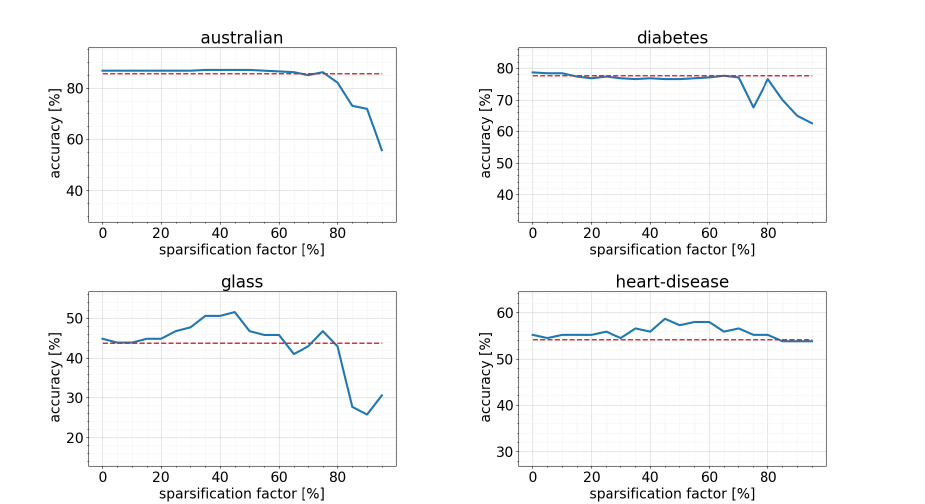
Figure 19. Results of pruning SVM structure on Australian, diabetes, glass and heart-disease